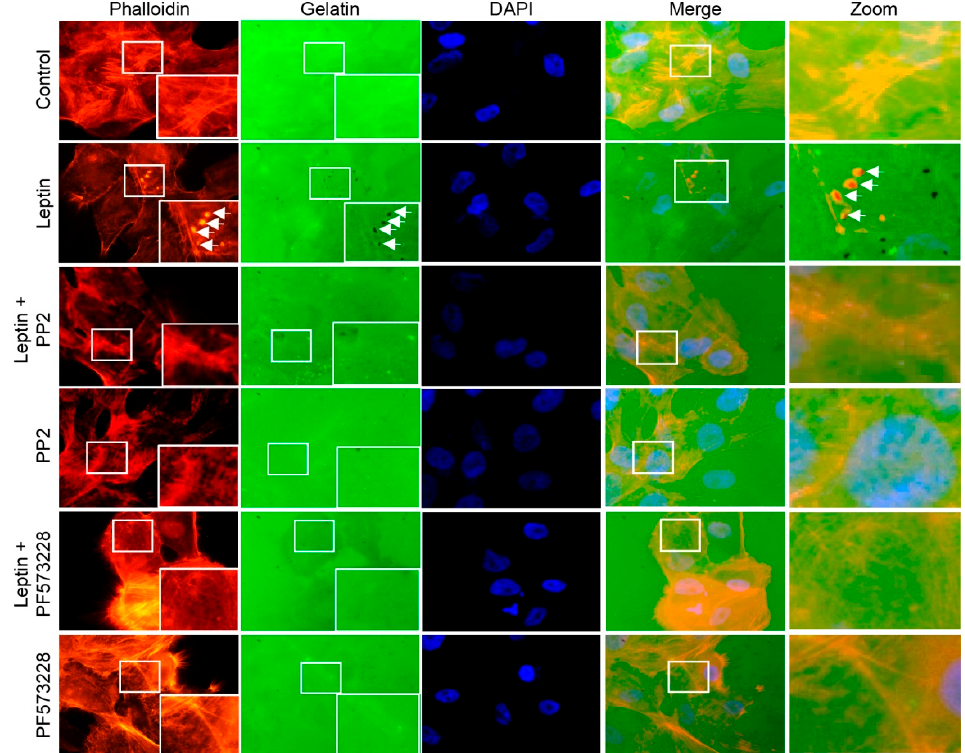
Figure 6. Src and FAK regulate the invasion capacity of MCF10A cells stimulated with leptin. Representative images of MCF10A cells pre-treated or not with PP2 or PF-573228 (10 µM) for 30 min and subsequently incubated in the presence or absence of leptin (400 ng/mL) for 24 h. Actin puncta was detected with phalloidin (red) and Alexa 488-labeled gelatin (green) was used as a specific substrate for the membrane-bound MMP-14 located at the edge of invadopodia. Arrows indicate areas of gelatin degradation. Images were acquired using a 100× magnification.